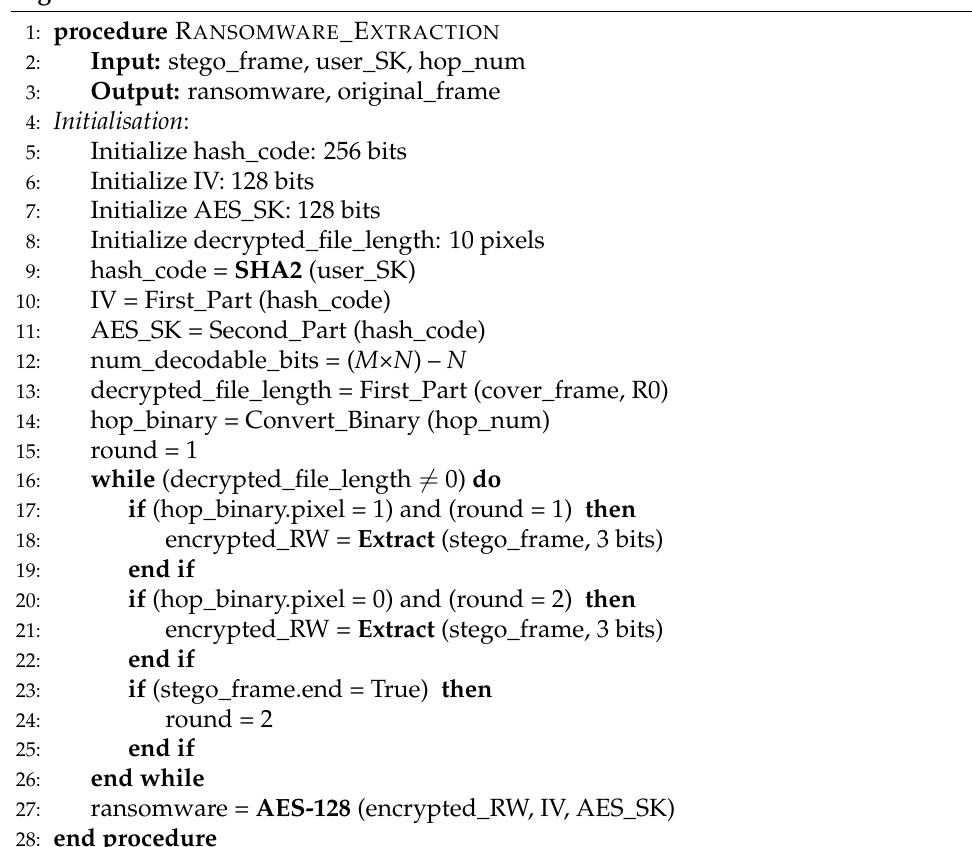
Algorithm 2 Ransomware Extraction